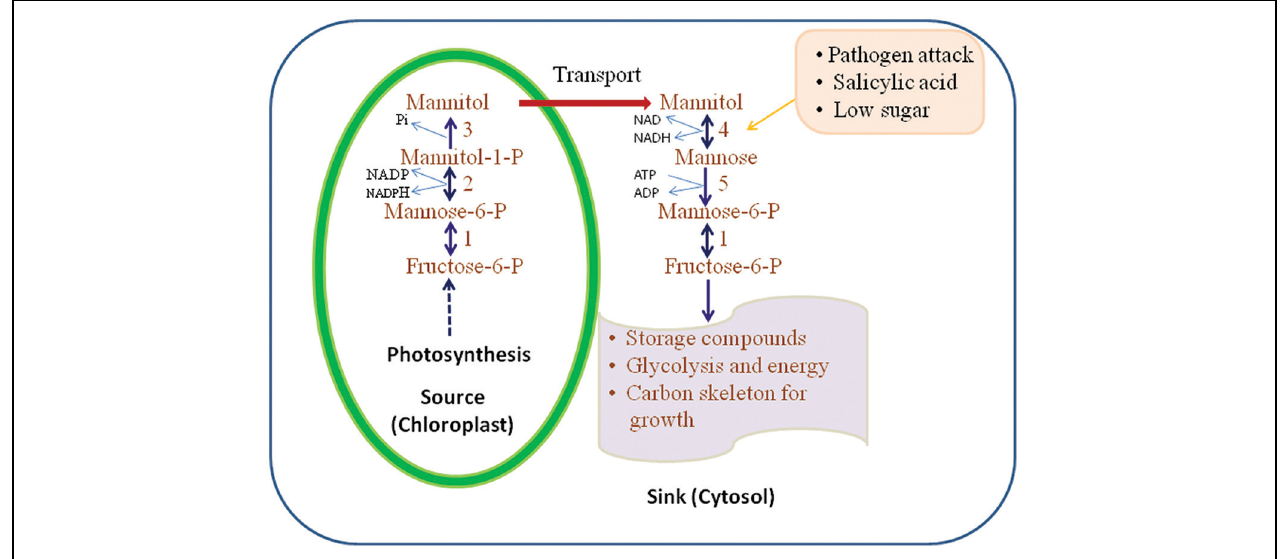
FIGURE 2 | Mannitol biosynthesis and catabolism as proposed in higher plants. 1, mannose; 6-P isomerise; 2, mannose-6-P reductase; 3, mannitol-1-phosphate dehydrogenase (M1PDA); 4, mannitol-1-dehydrogenase; 5, hexokinase (HX; adapted and modified from Stoop et al.,